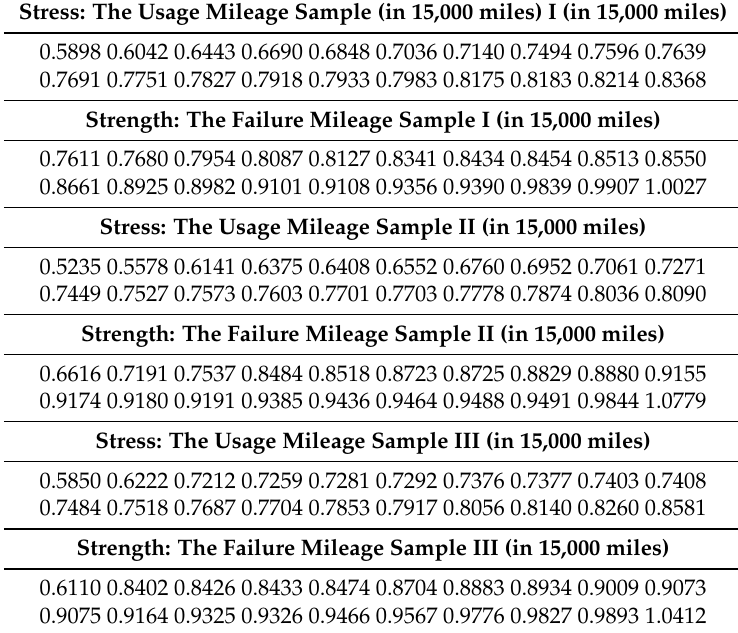
Table 9. Three progressively first-failure censored samples from two Burr type XII distributions.